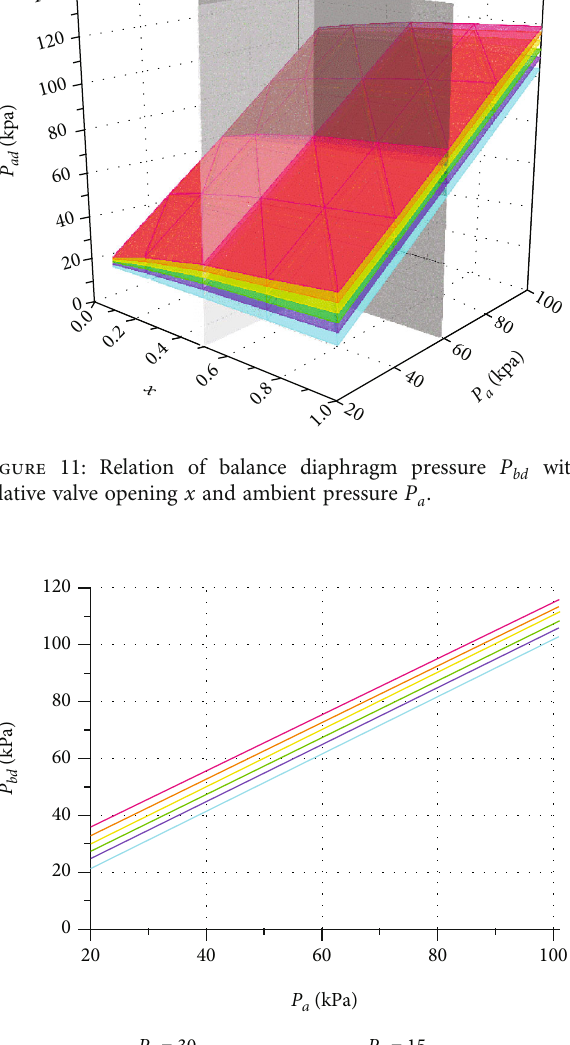
Figure 10: Relation between actuator diaphragm pressure P relative valve opening x at di ff erent di ff erential pressure P d .